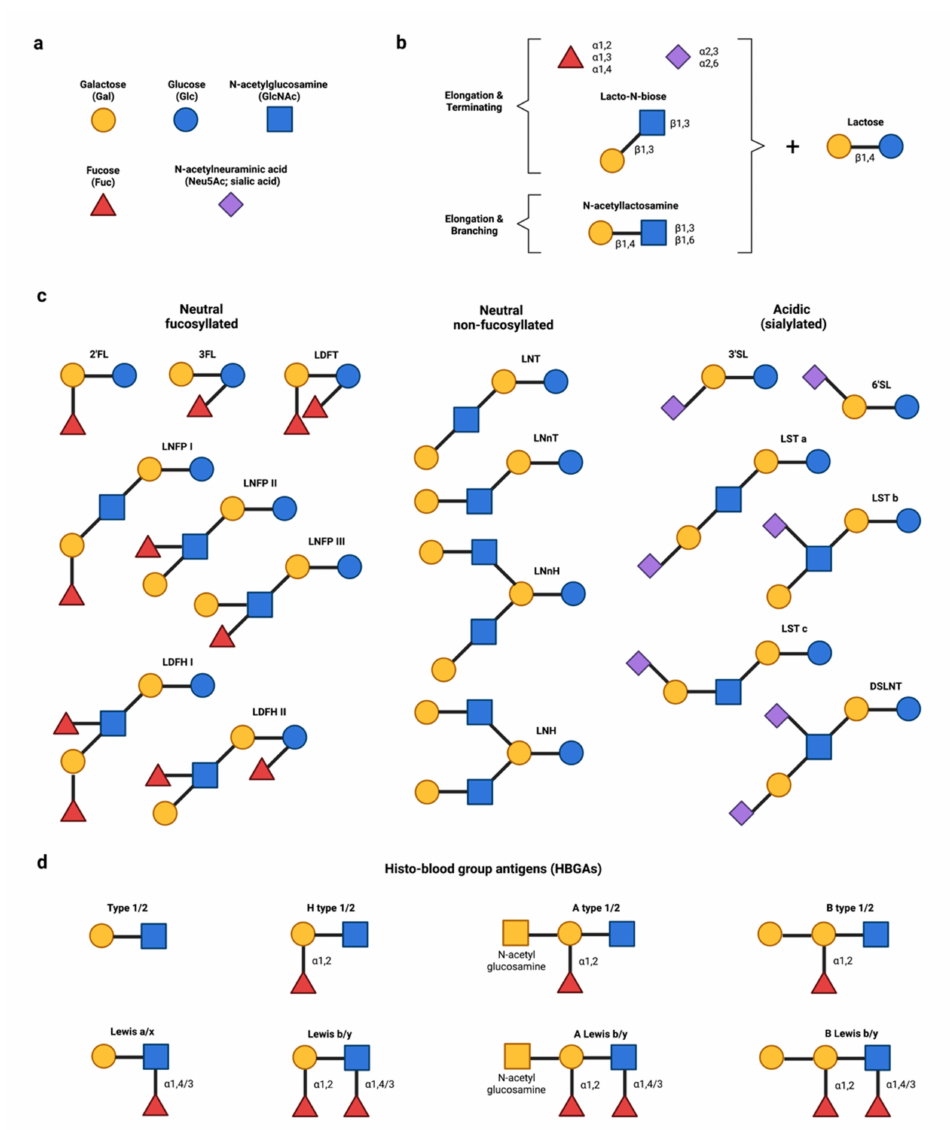
Figure 1. Structural diversity of hMOS and their analogous human blood group antigens (HBGAs). ( a ) HMOS are constituted from five different monosaccharides. ( b ) All hMOS have lactose at the reducing end as the building block. The structural diversity of hMOS is due to combinations of elonga- tion with N-acetyllactosamine, Lacto- N -biose, fucose and/or sialic acid. ( c ) Selected hMOS structures commonly found in human milk, some of which are further discussed in this review. ( d ) HBGAs serve as attachment receptors for several viruses. Fucosylated hMOS (e.g., 2 (cid:48) FL) can structurally mimic receptors, thereby acting as decoys (competitive inhibitors) of HBGAs. Abbreviations: 2 (cid:48) FL, 2 (cid:48) -fucosyllactose; 3FL, 3-fucosyllactose; 3 (cid:48) SL, 3 (cid:48) -sialyllactose; 6 (cid:48) SL, 6 (cid:48) -sialyllactose; hMOS, Human milk oligosaccharides; DSLNT, Disialyllacto- N -tetraose; LDFH, Lacto- N -difucohexaose; LDFT, Lac- todifucotetraose; LNFP, Lacto- N -fucopentaose; LNH, Lacto- N -hexaose; LNnH, Lacto- N -neohexaose; LNT, Lacto- N -tetraose; LNnT, Lacto- N -neotetraose; LST, Sialyllacto- N